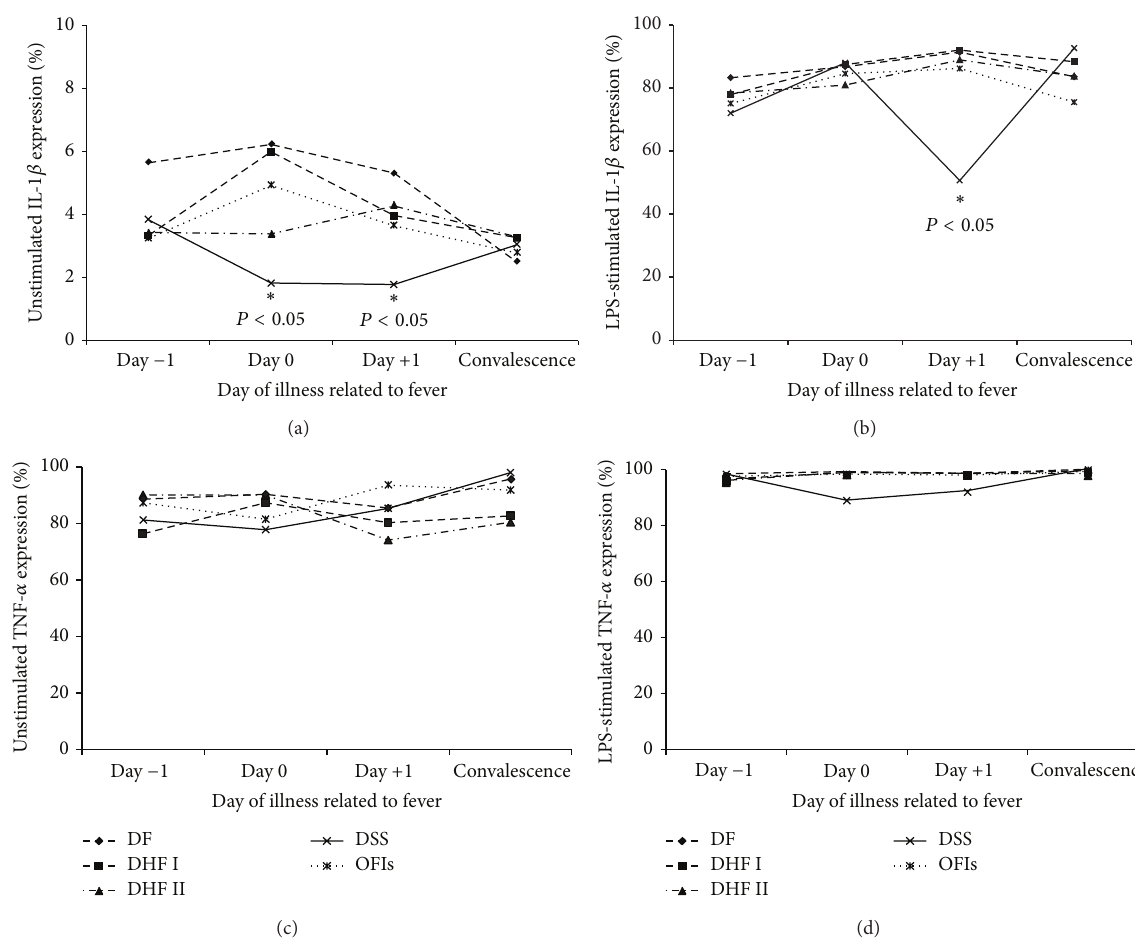
Figure 2: Mean levels of % expression of unstimulated and LPS-stimulated intracellular IL-1 𝛽 ((a) and (b)) and mean levels of % expression of unstimulated and LPS-stimulated intracellular TNF- 𝛼 ((c) and (d)) in monocytes of DF, DHF grades I and II, DSS, and OFIs patients, followed by the day of illness related to